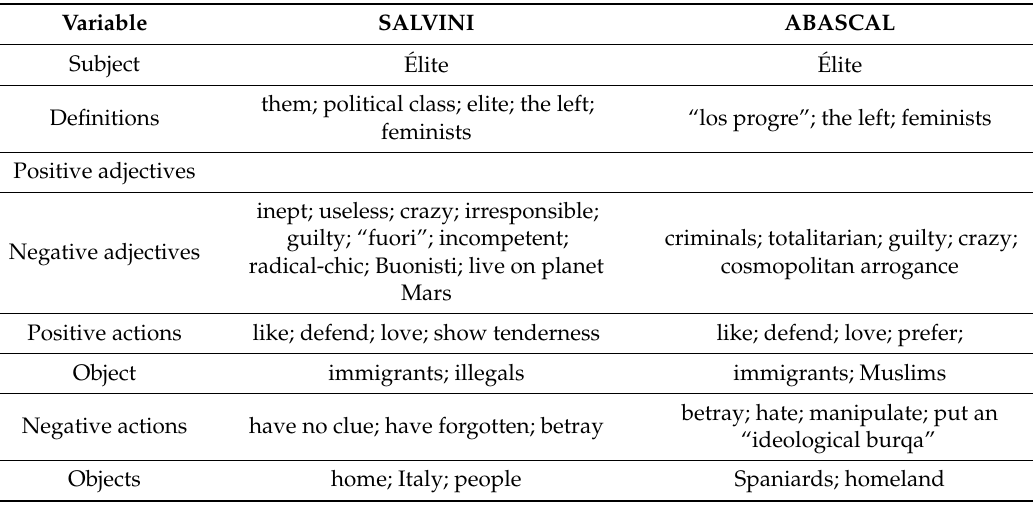
Table 4. The other “them” actor: the é